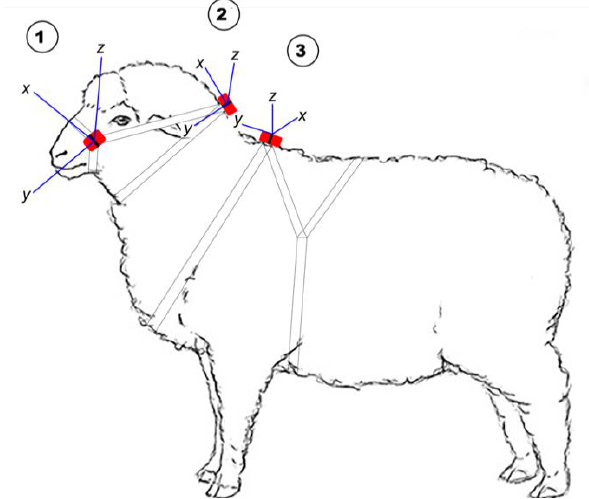
Figure 1. The position of the Actigraph tri-axial accelerometer on 1 (head halter), 2 (neck collar) and 3 (body harness) and the axis orientation at each position in relation to the animal’s body.